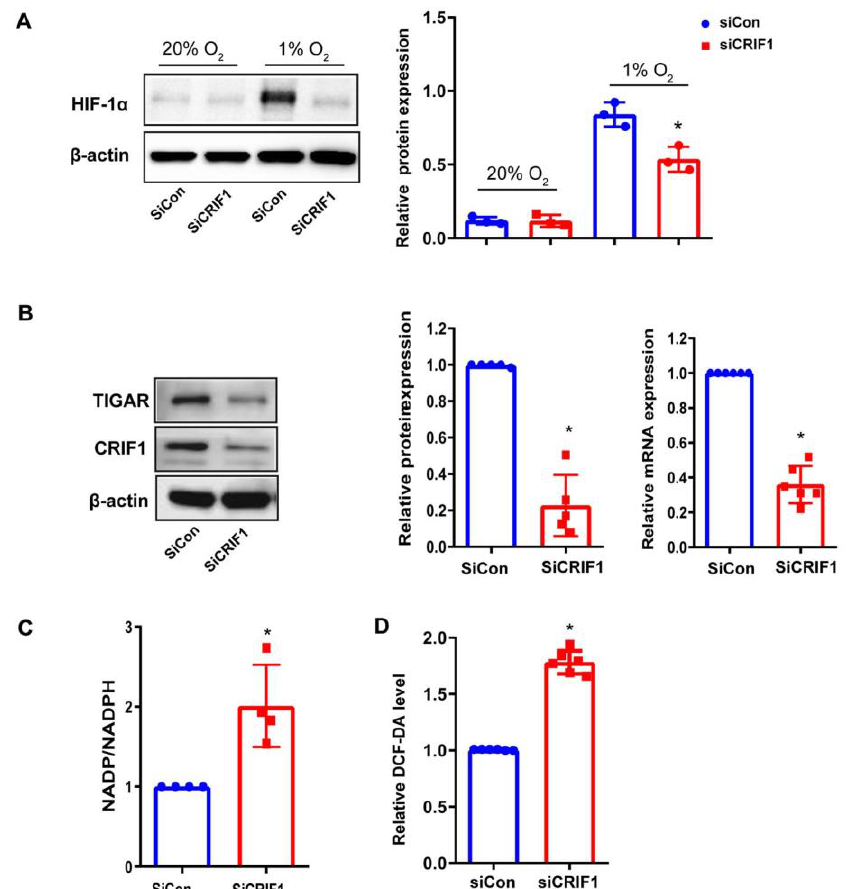
Figure 4. CRIF1 deficiency inhibited hypoxia-induced expression of HIF-1 α and led to elevated intracellular ROS levels in MCF-7 cells. ( A ) MCF-7 cells were transfected with 100 pmol of siCon and siCRIF1 and then incubated in 20% and 1% O2 incubator for 48 h, respectively. Western blot analysis of HIF-1 α ( B ) mRNA and protein expression of TIGAR were measured by qPCR and immunoblotting, respectively. ( C ) Total NADP/NADPH ratio and ( D ) DCF-DA fluorescence intensity were measured by using a colorimetric/fluorometric assay kit. All data are presented as means ± SEM of at least three independent experiments. * p < 0.05 compared with siCon group.